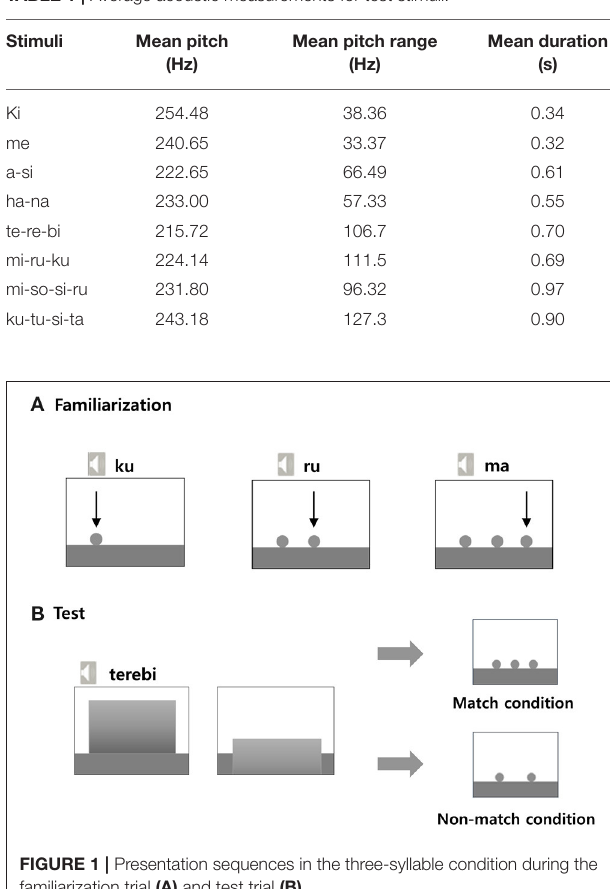
also asked not to look at the display and not to interact with the child during the session. Presentation of the stimuli on the display were performed using Tobii Pro Studio V3.2. The child’s